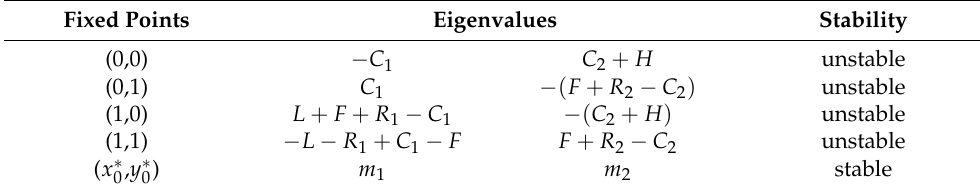
Table 3. The eigenvalues of Jacobi matrix J and stability. Fixed